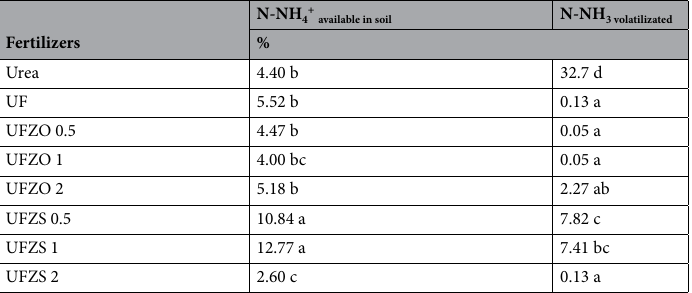
Table 1. N recovery from the fertilizers as N-NH 4+ available, and N-NH 3 volatilized, after 42 days soil incubation. The data shows average values of each N fraction derived of total N applied to the soil as urea, UF or composites. (UF = pure polymers, UFZO = composites with ZnO and UFZS composites with ZnSO 4 ). The estimative of N recovery percentage was calculated by the total N content present in the composites (10 mg of N) subtracted by the N content converted into ammonium or ammonia extracted from the soil (determined by colorimetric or titulation method). *Values within a column followed by the same letter do not differ significantly (Tukey’s test; P < 0.05) with n = 4 replicates.